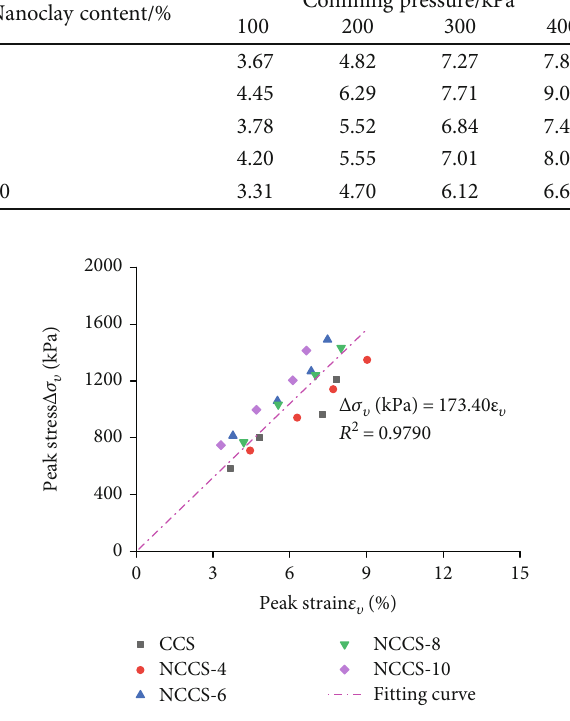
Figure 3: Relation of peak stress and peak strain of